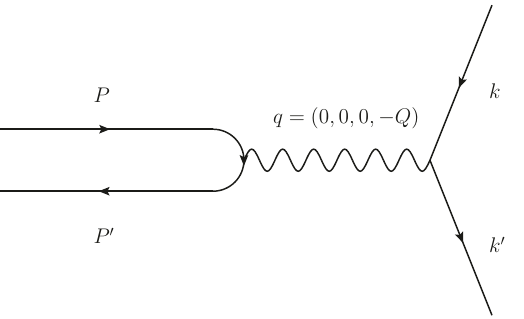
Figure 1 . An illustration of the basic hard scattering process in the Breit frame with incoming proton momentum P , incoming lepton momentum k , virtual boson exchange momentum q , outgoing proton momentum P 0 and outgoing lepton momentum k 0